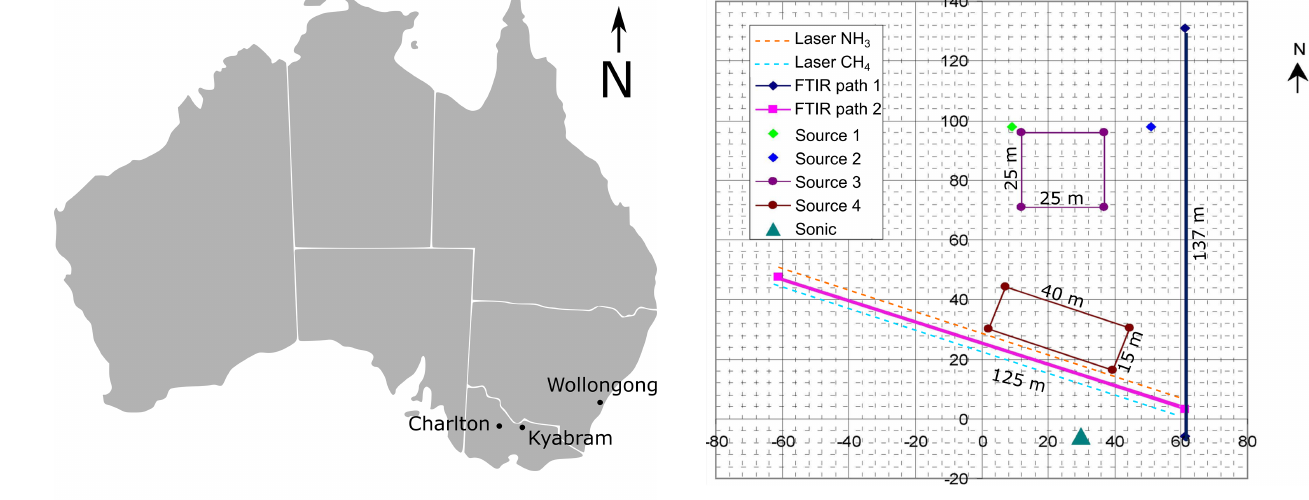
Figure 2. Point and area gas release sources and OP sensor path geometries (distances in m) at Kyabram in July–August 2005. Point source 1 is in green and 2 is in blue. Area source 3 is 25 × 25m, and area source 4 is 40 × 15m. The OP-FTIR measurement path lengths 1 and 2 were 137 and 125m (two-way path), respectively. OPL NH 3 and CH 4 sensors were parallel to OP-FTIR path 2 (dashed yellow and blue lines respectively). Sonic anemometer was located to the south of the site (dark green